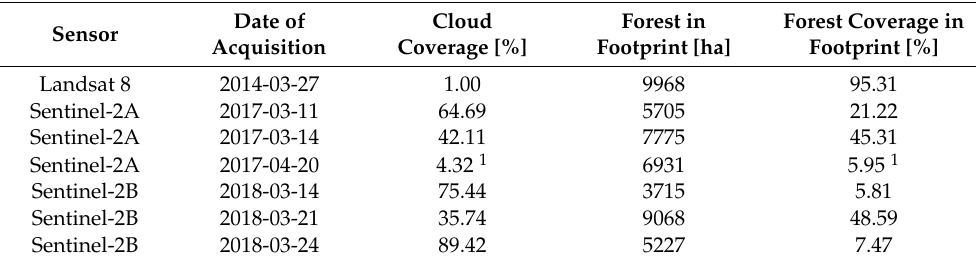
Table 3. List of satellite images used in the